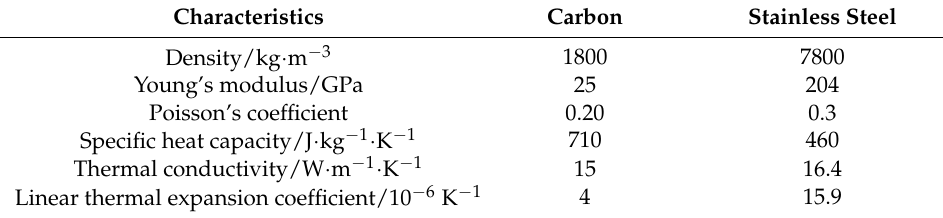
Table 2. Characteristics of the materials.